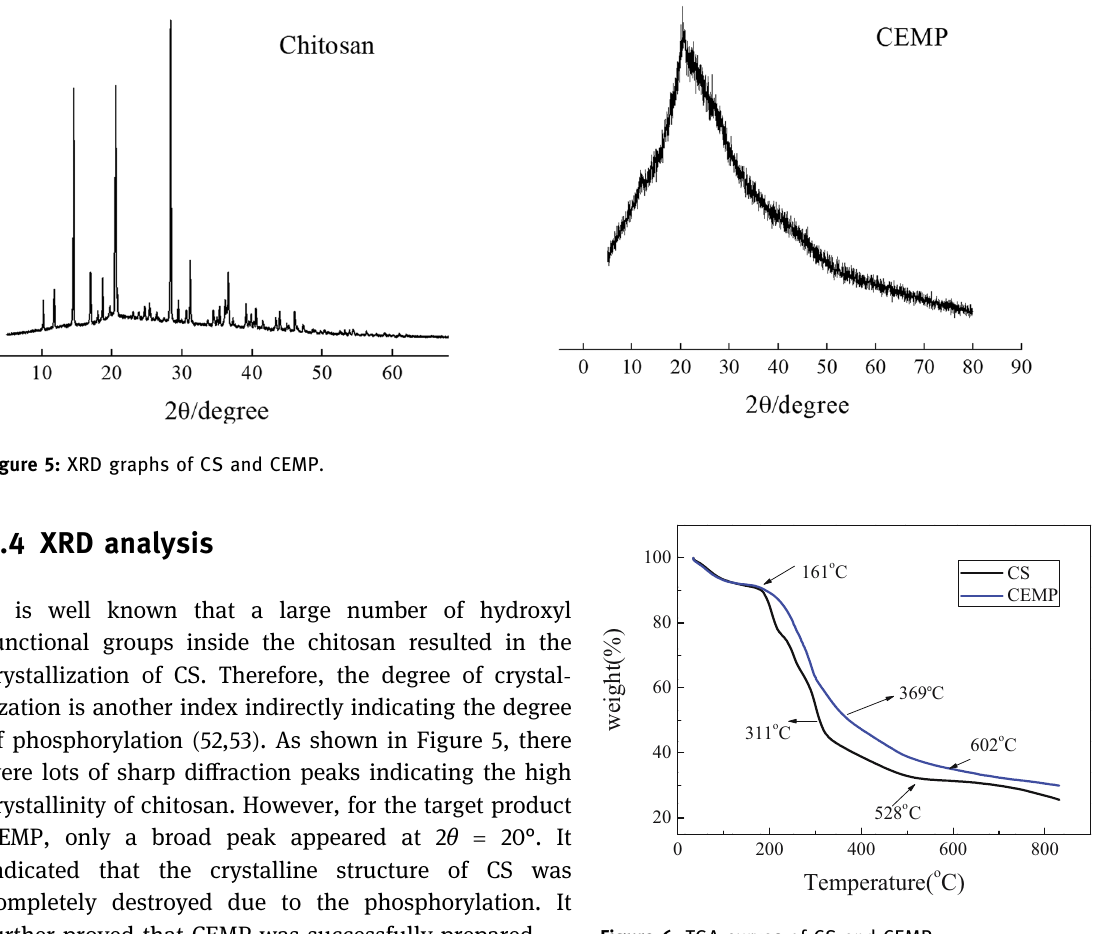
Figure 6: TGA curves of CS and